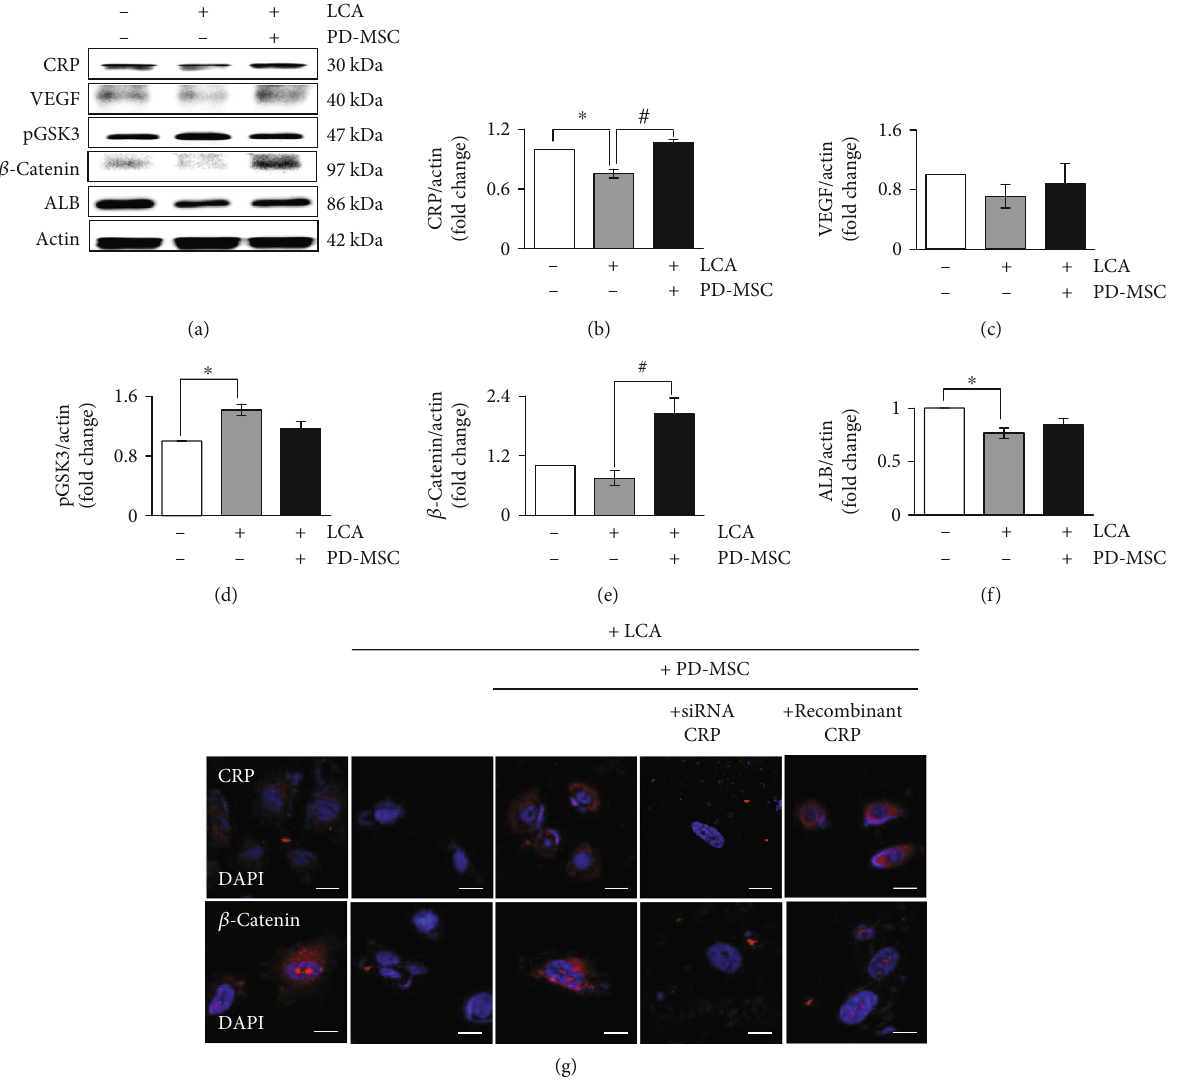
Figure 5: The e ff ect of PD-MSC and CRP for WB-F344 in the protein level. The protein levels of CRP, VEGF, Wnt signaling factors, and ALB were detected in WB-F344s treated with LCA and cocultivated with HUVECs and PD-MSCs (a). Graph of intensity was normalized to that of actin for CRP (b), VEGF (c), pGKS3 αβ (d), β -catenin (e), and ALB (f) ( n = 2 per group, ∗ control group and # LCA-treated group vs. p < 0 : 05 ). Data were represented as the mean ± SD . Representative images of immuno fl uorescence were stained with WB-F344s for CRP and β -catenin after LCA or recombinant CRP treatment, transfection of siRNA-CRP, and cocultivation of PD-MSCs (g). Scale bars: 20 μ m. ALB: albumin; LCA: lithocholic acid-treated group; PD-MSC: PD-MSC cocultivated